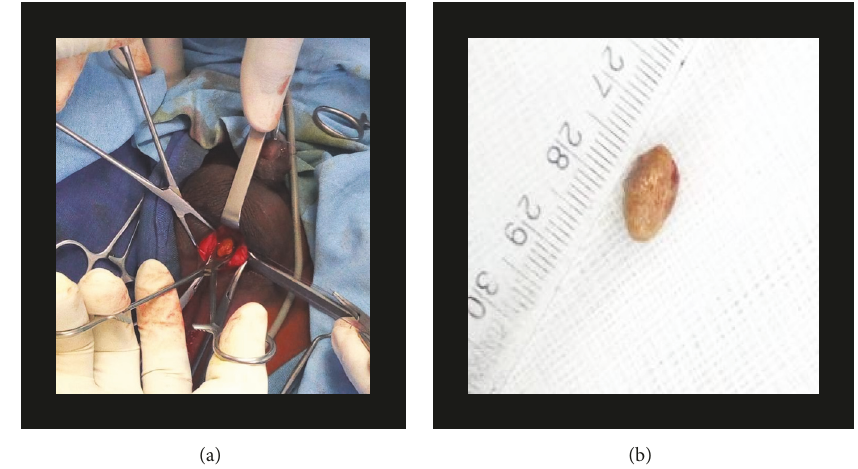
Figure 10: (a) Urethral calculus, in situ (case 2). (b) Extracted calculus (case